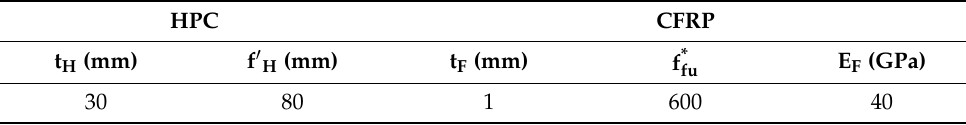
Table 3. Mechanical properties of the retrofit system.